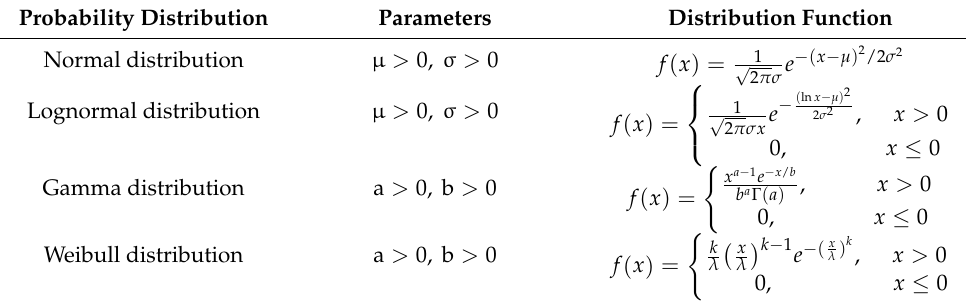
Table 2. The density functions of probability distributions. Probability